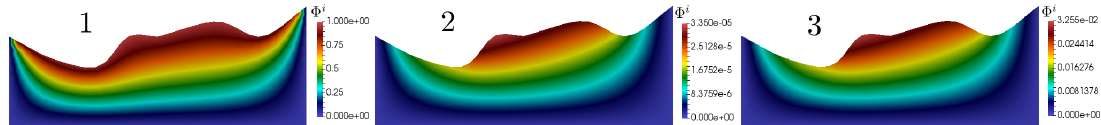
Figure 3. Illustration of the additional multiscale basis function. Left : The solution of the problem (12). Middle : The solution of the problem (13). Right : The solution of the problem (14).